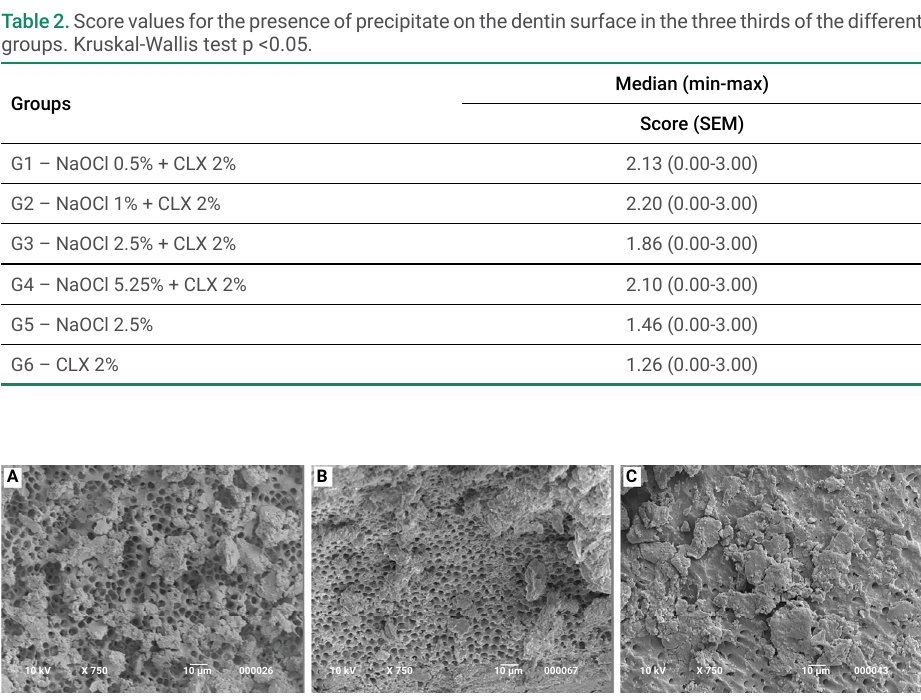
Figure 5. SEM images (magnification 750x) of dentin surface after irrigants association showing precipitate formation in the cervical (a) and middle (b) thirds.